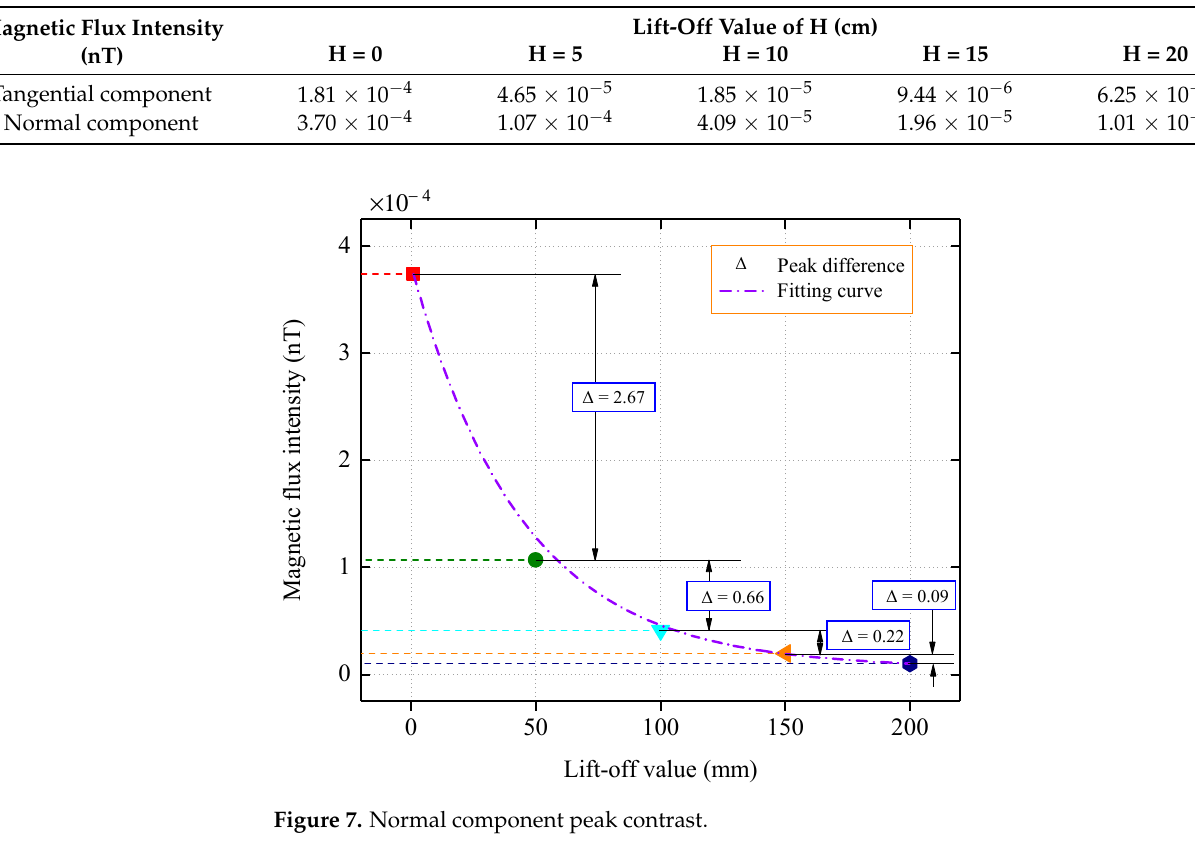
Table 2. Peak value of magnetic flux intensity under different lift-off values.